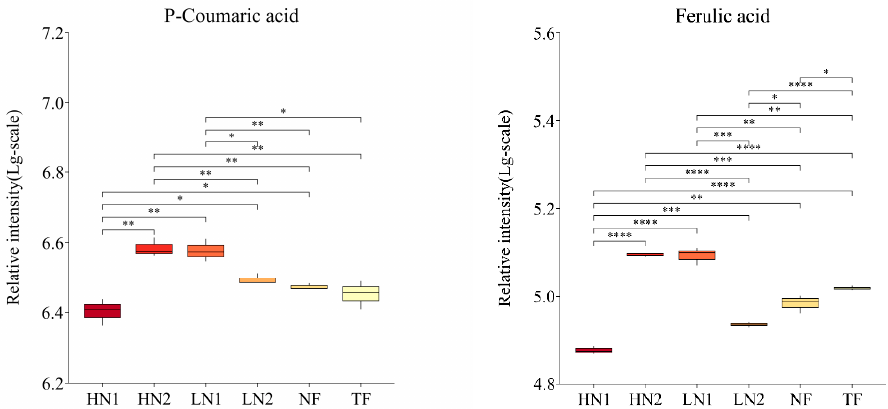
Figure 6. The changes in ferulic acid and p-coumaric acid contents in tea leaves with different N supplies. The statistical approach used was a two-tailed t -test. Every group contains 3 tea leaf samples. ****, ***, **, * indicates a significant difference at p < 0.0001, p < 0.001, p < 0.01, and p < 0.05,